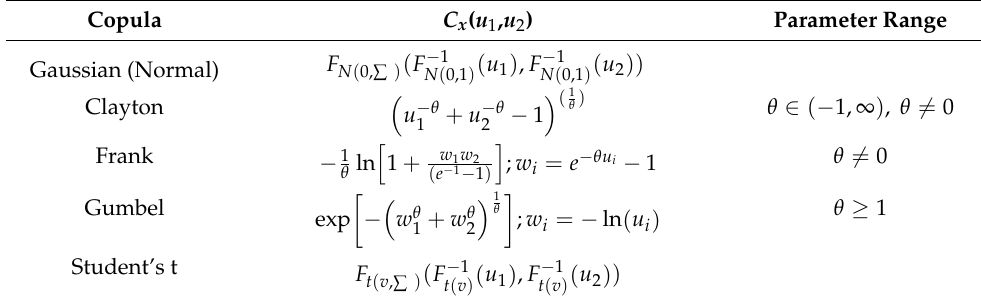
Table 1. Cumulative distribution functions and parameter ranges of obtained copula family. Copula C x ( u 1 , u 2 ) Parameter Range Gaussian